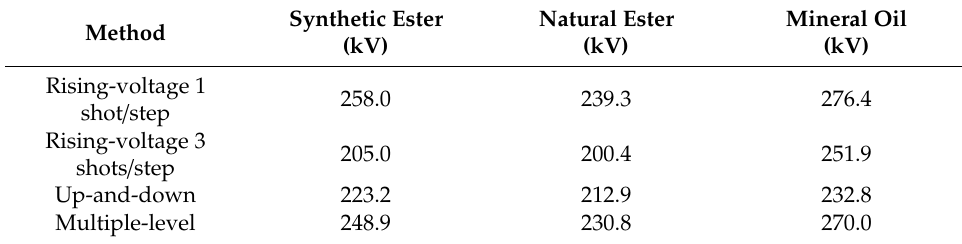
Table 3. 50% LIBVs of the liquids tested with the use of various methods, d = 3.8 mm